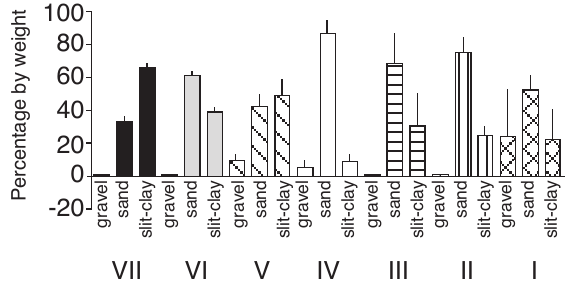
F IG . 3. – Percentage composition by weight and standard deviation (vertical bars) of sediment texture in the seven benthic